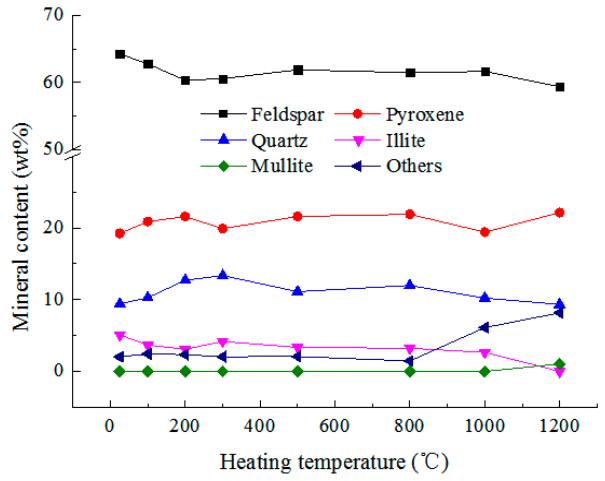
Figure 5. Mineral contents of granite specimens at different temperatures. Table 1. The maximum diffracted intensity (MDI) of the main minerals at different temperatures.